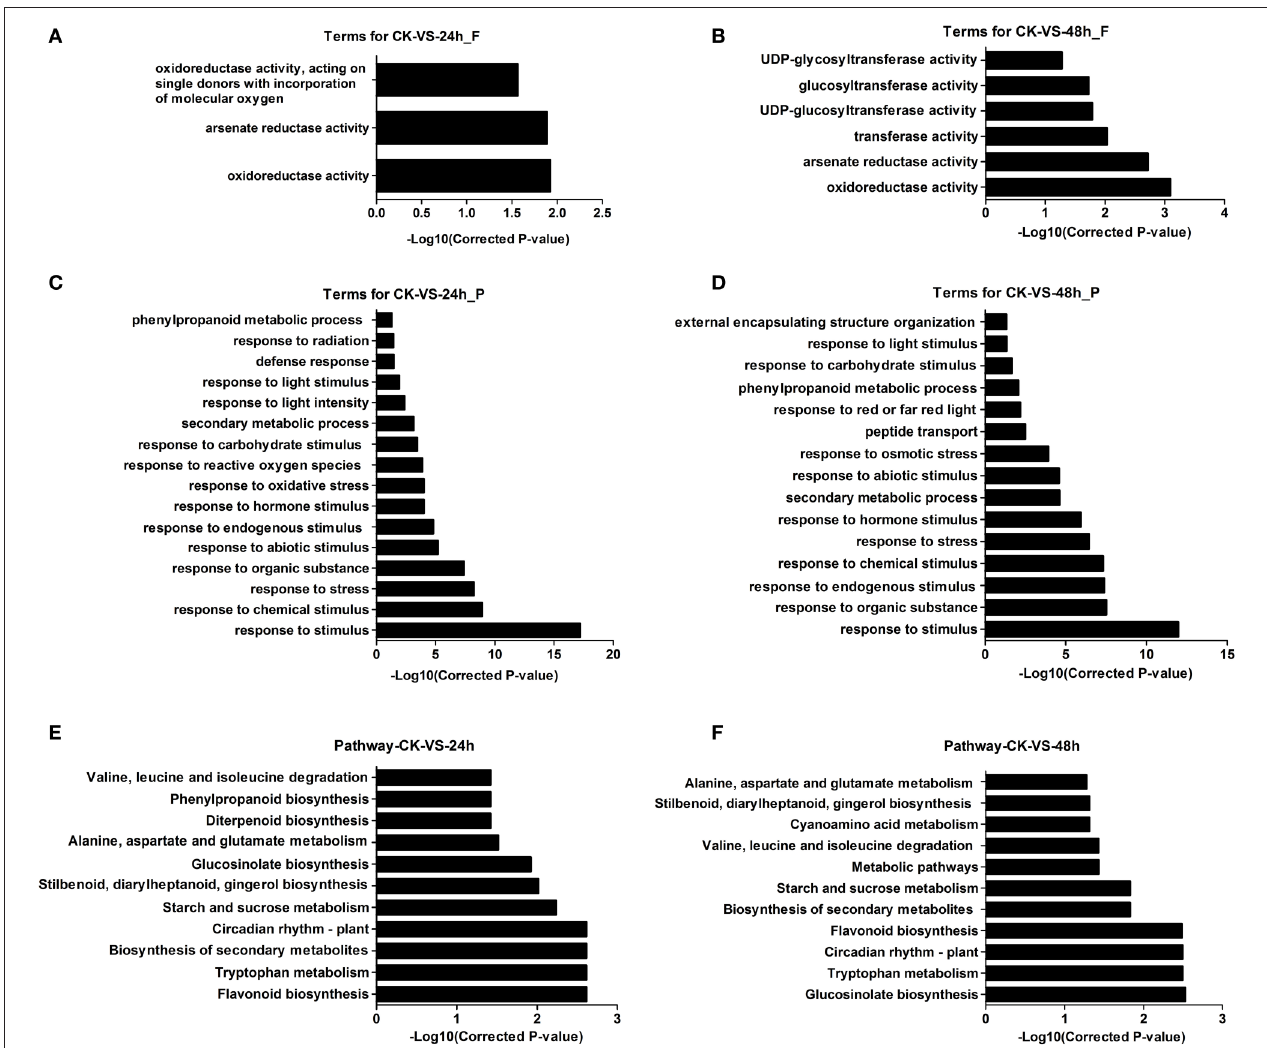
FIGURE 3 | GO and pathway analyses of DEGs in A. thaliana during early infection by P. brassicae. (A,B) show the function analysis result, (C,D) show the process result and, (E,F) show pathway